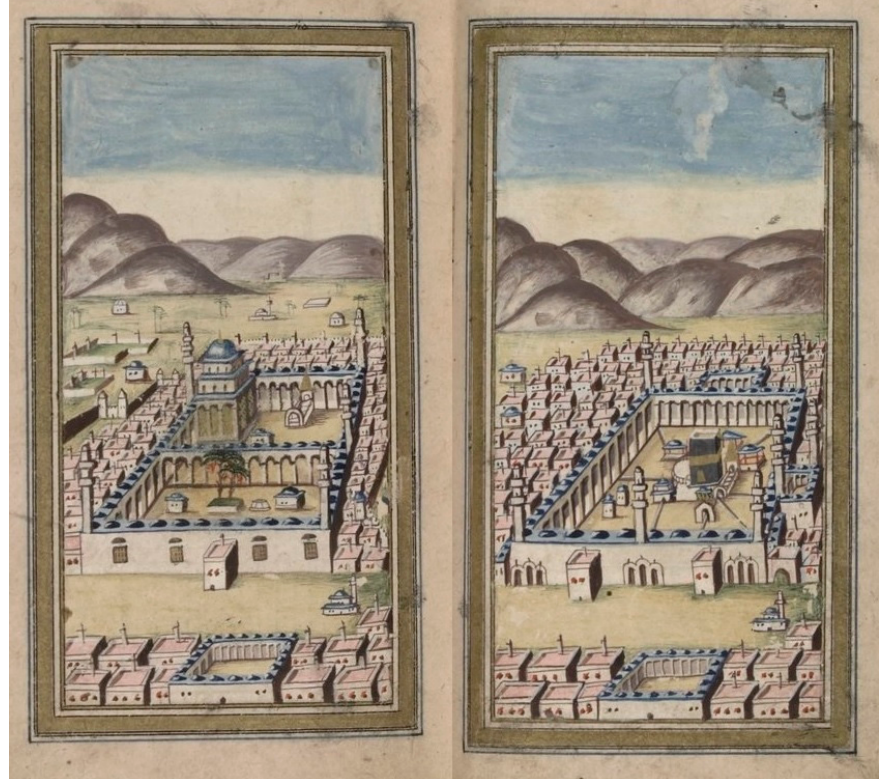
Figure 2. Cavalier perspectival views of Mecca (right) and Medina, from a 1772 copy of the Dal ā ’il al-khayr ā t , the body of the text written by one Ḥ ā fi ẓ Mu ḥ ammad ibn Ḥ ā fiz Ibr ā h ī m Mevlev ī , im ā m of the Mur ā diye Camii in Edirne. Library of Congress, BP183.3.J39 1772 Arabic MSS, fol. 23b-24a.